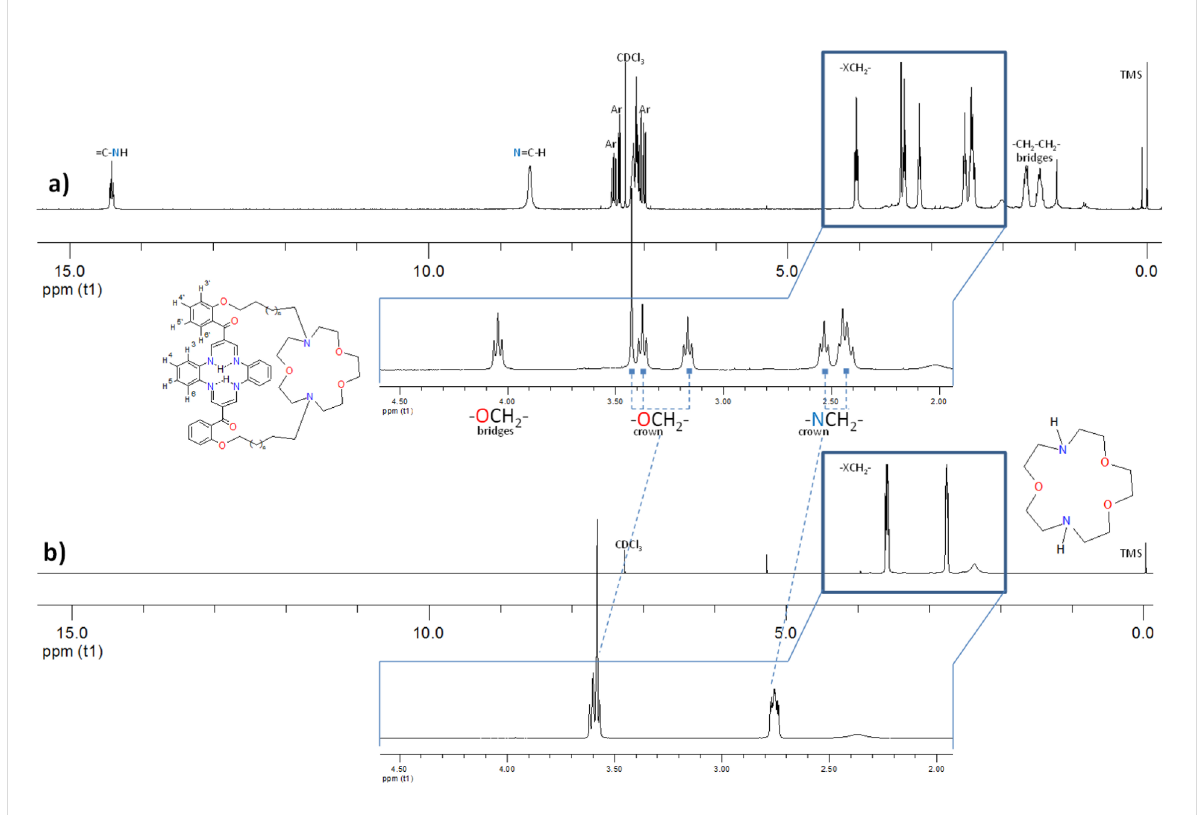
Figure 2: 1 H NMR spectra (298 K, CDCl 3 ) of: a) crown ether-capped receptor 3b and b) it’s corresponding parent 1,7-diaza-15-crown-5. The insets show an enlarged portion of 1 H NMR spectra showing signals attributed to the crown ether ethylene protons.